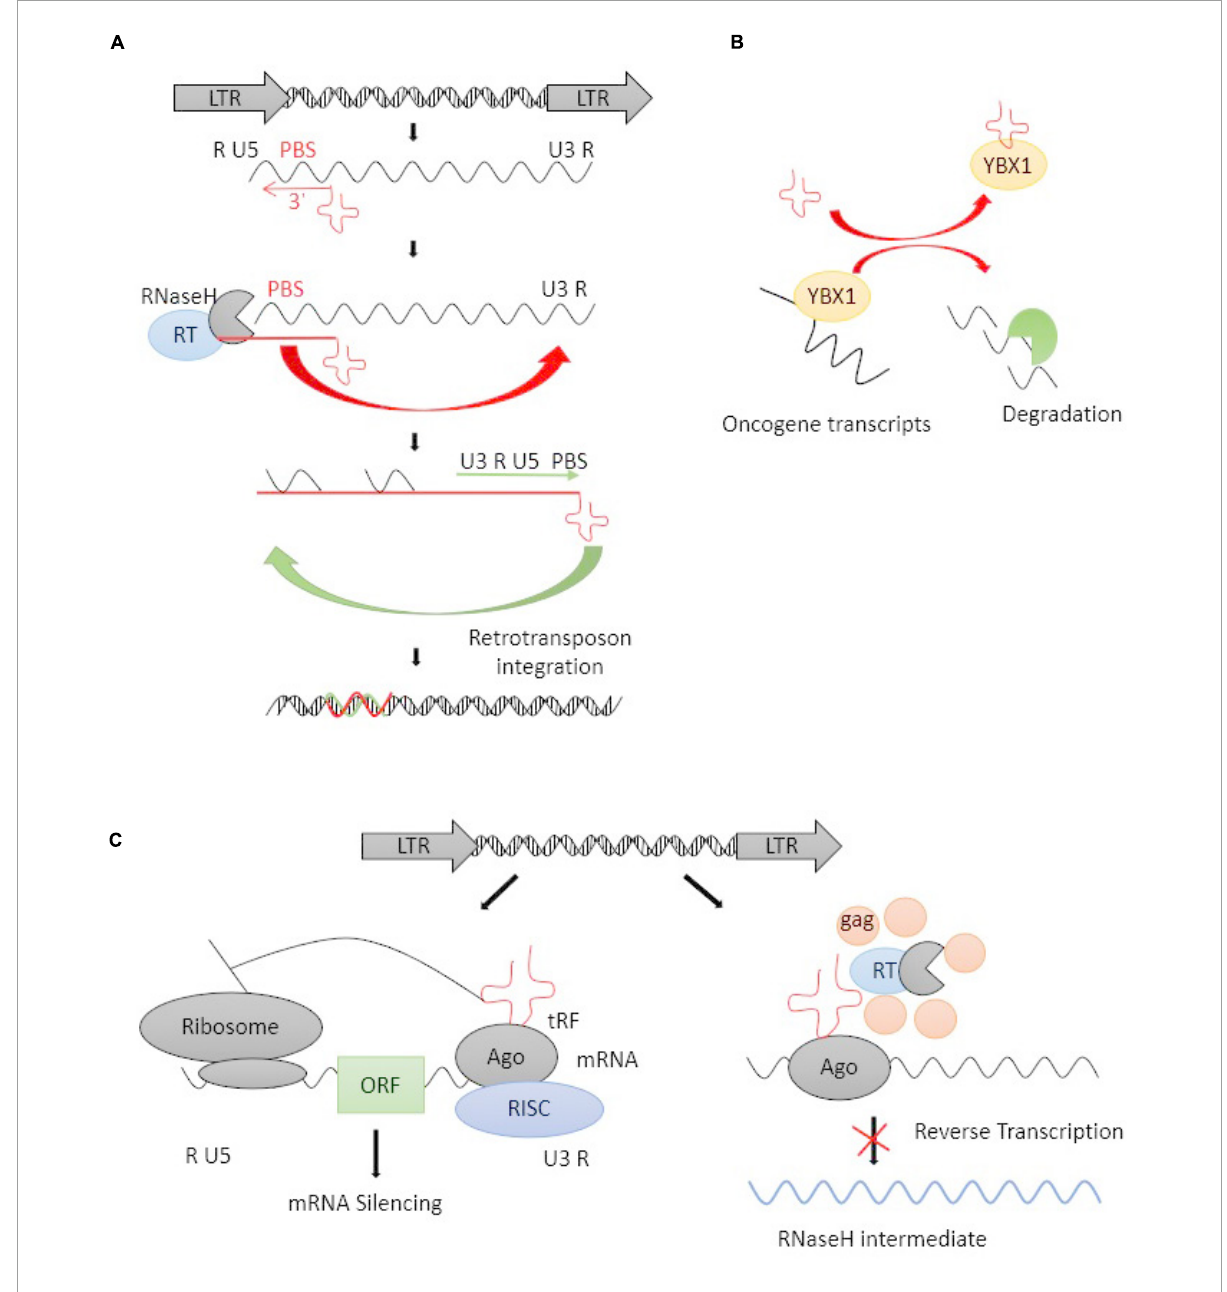
FIGURE2 The life cycle of an LTR retrotransposon and tRFs-mediated inhibition. (A) Schematic representation of the life cycle of an LTR retrotransposon. The LTR encodes promoter elements and termination signals. The 3 (cid:48) -tRFs (red cloverleaf) primes RT by hybridizing to PBS. After transfer events, a double-stranded retroviral DNA is integrated into the host genome. (B) tRFs competitively bind with YBX1 and caused oncogene transcripts degradation. (C) tRFs function as potential inhibitions at the posttranscriptional and RT levels. tRFs loaded into argonaute (AGO) protein and other proteins form an RNA-induced silencing complex (RISC), thus inducing RNAi on target mRNAs (right panel). tRFs inhibit RT by directly targeting their PBS and inhibiting retrotransposon’s replicative cycle (left panel).